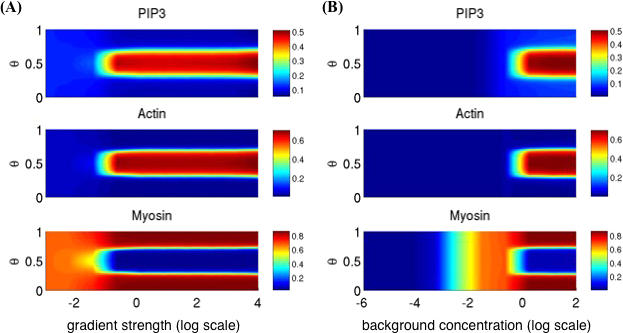
Dynamic Range of Gradient Sensing MechanismThe formula for the chemoattractant concentration on the surface of the cell as a function of the gradient strength (gL) and background concentration (bL) is given in the text.(A) Steady-state distribution of PIP3, actin, and myosin in response to chemoattractant gradients of increasing steepness with the background concentration of chemoattractant fixed at bL = 1.(B) Steady-state distribution of PIP3, actin, and myosin for a 10% gradient (gL = 10%) with increasing background concentrations of chemoattractant.